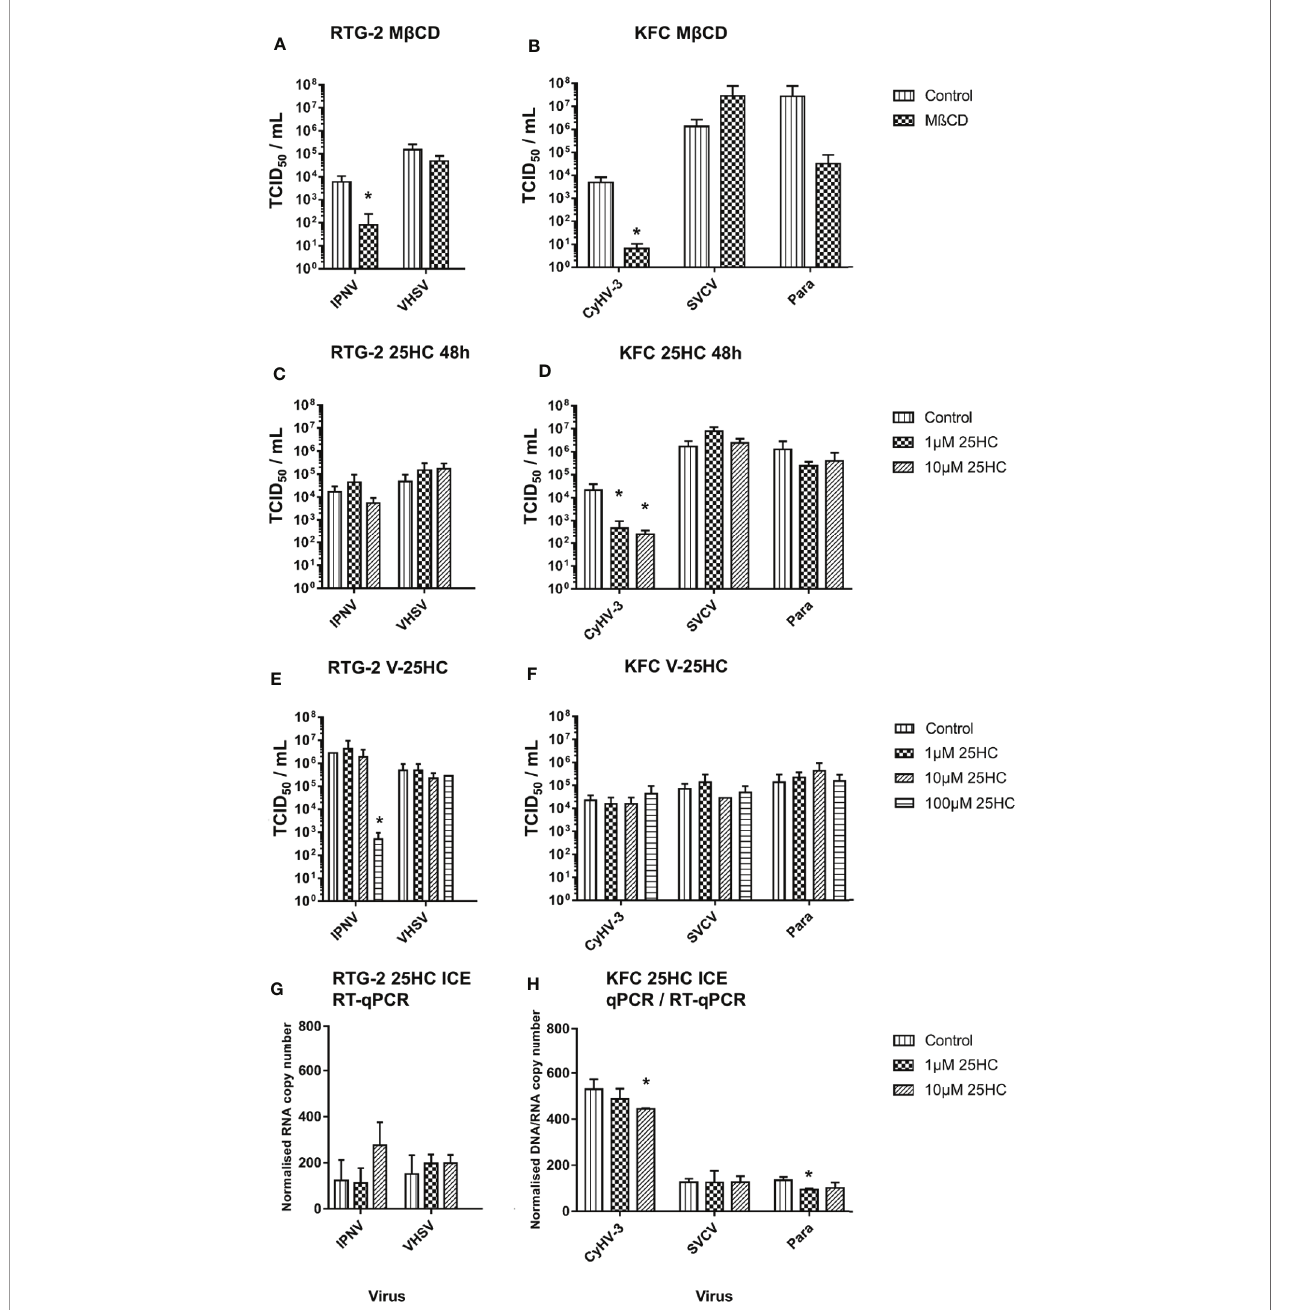
FIGURE 5 | Effect of an incubation of carp cells (KFC) or rainbow trout gonad (RTG-2) cells with (A, B) methyl- b -cyclodextrin (M b CD) and (C, D) 25- hydroxycholesterol (25HC) prior to infection with CyHV-3, infectious pancreatic necrosis virus (IPNV), a carp pathogenic paramyxovirus (Para), SVCV, or VHSV. (E, F) effect of an incubation of the above mentioned viruses with 25HC prior to the infection of the cells on virus replication, monitored by TCID 50 titering. (G, H) Effect of 25HC pre-treatment on attachment of the viruses measured after 2h post-infection on ice using qPCR or RT-qPCR. Data presented as a bar indicating mean TCID 50 /ml or normalized DNA/RNA copy numbers (+SD) from n = 3 replicates. * indicates a statistically signi fi cant difference at p < 0.05 between control and the treatments. Analysis was performed with one-way ANOVA with subsequent pairwise multiple comparisons using the Holm- Sidak